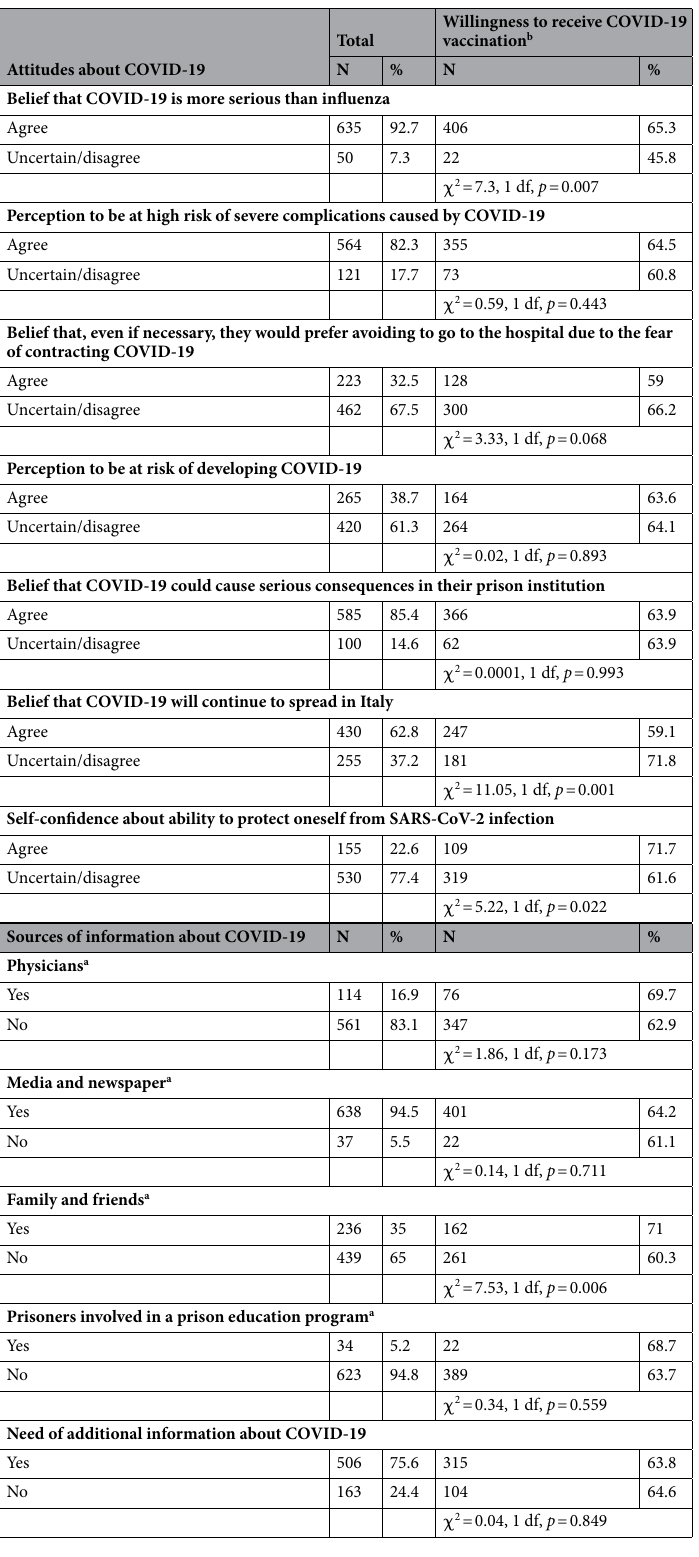
Table 3. Attitudes about COVID-19 and the associated willingness to receive COVID-19 vaccination (N = 865). a Number for each item may not add up to total number of study population due to missing values. b The frequency values of the respondents regarding the willingness to receive COVID-19 vaccination do not refer to the total number of the selected population due to the missing